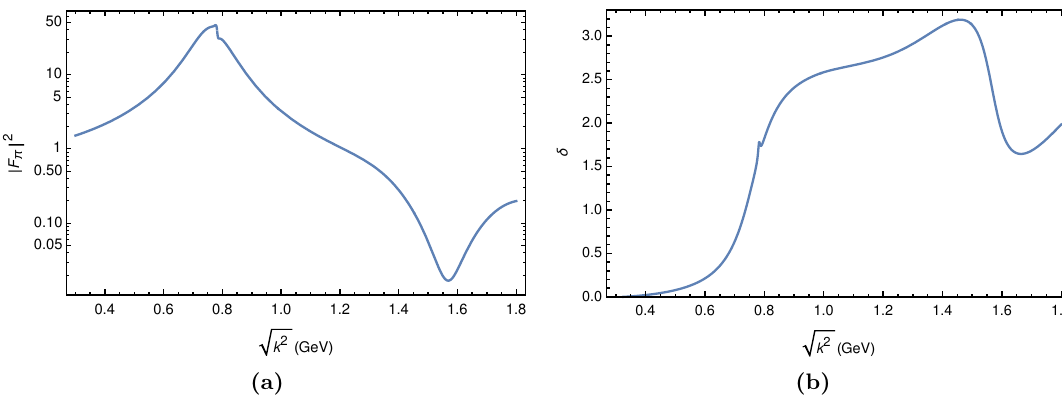
( k 2 ) = j F em j e i(cid:14) in the time-like (cid:25) (cid:25)